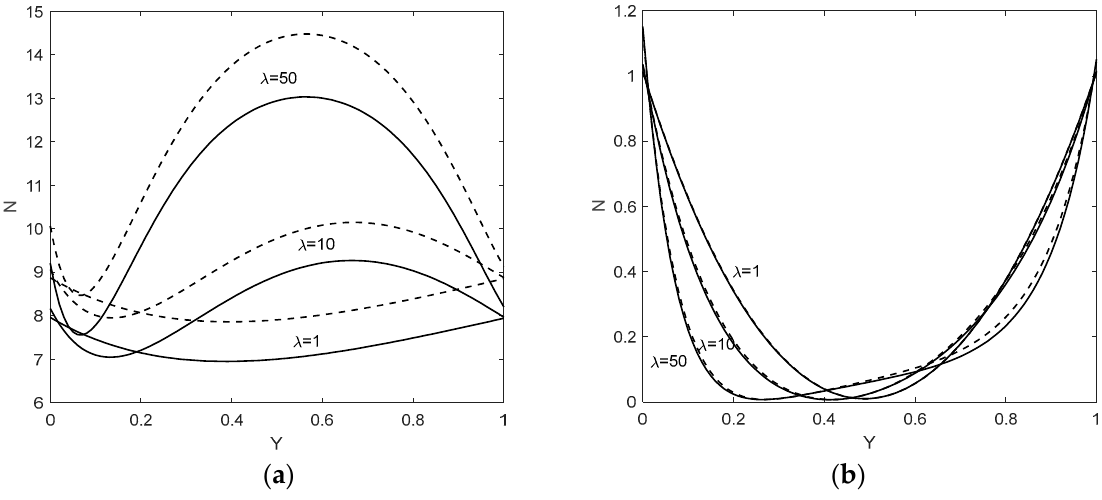
Figure 8. Entropy generation number for Pe = 1 ( a ) and for Pe = 10 ( b ), for λ = 1, 10, 50 and γ = π , depicted with a straight line for ϕ 1 = 0.1, ϕ 2 = 0.0 (regular nanofluid) and with a broken line for ϕ 1 = 0.1, ϕ 2 = 0.02 (hybrid